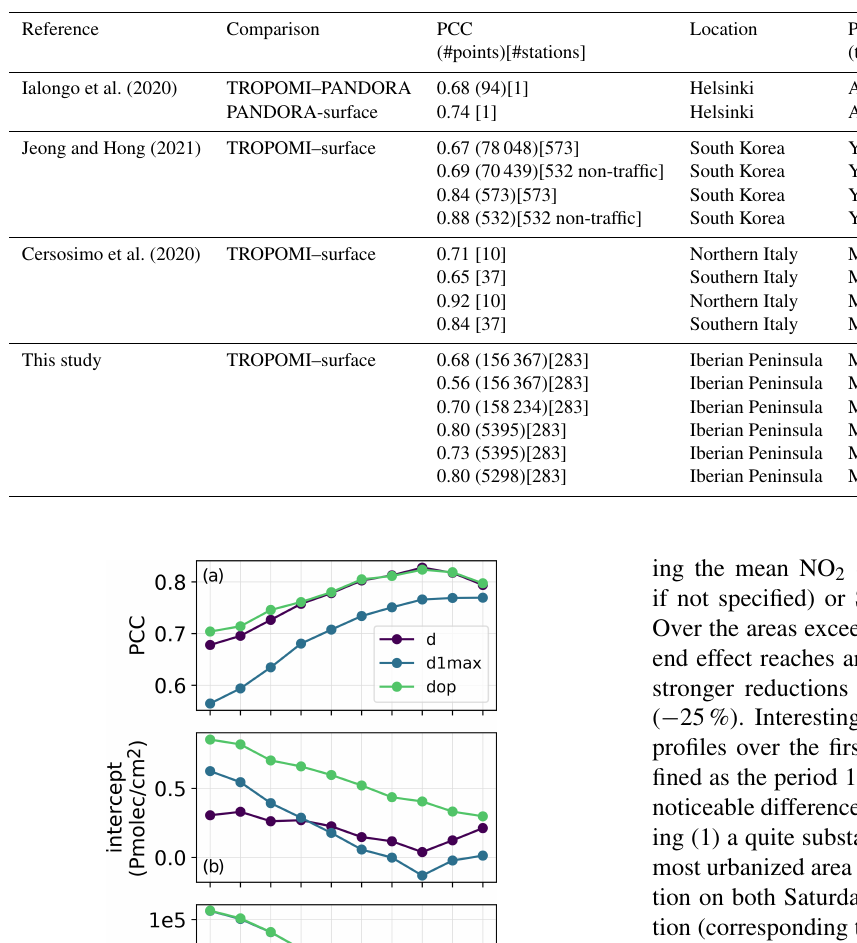
Table 3. Pearson correlation coefficients (PCCs) between TROPOMI-based or PANDORA-based TrC-NO 2 and surface-based NO 2 mixing ratios in the recent literature, considering different timescales: daily mean (d), daily 1h maximum (d1max), daily TROPOMI overpass (dop) and monthly (m). When available, information on the number of points and stations is reported.